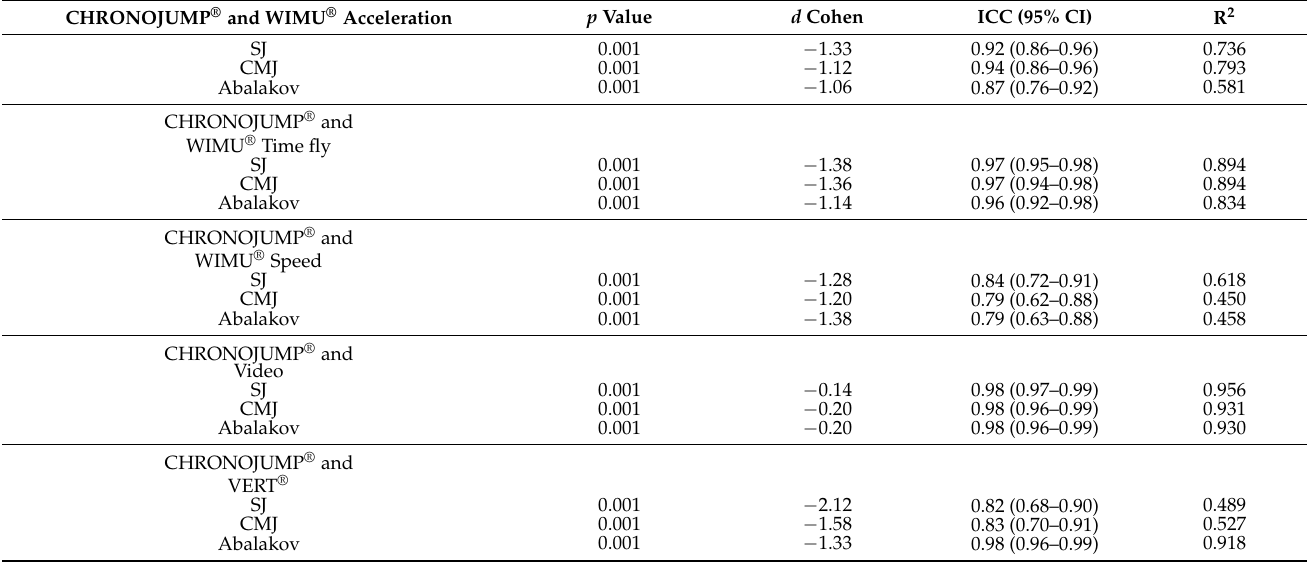
Table 2. Inferential data ( p value, d Cohen, ICC and R 2 ) after the comparison between Chronojump ® and the rest of